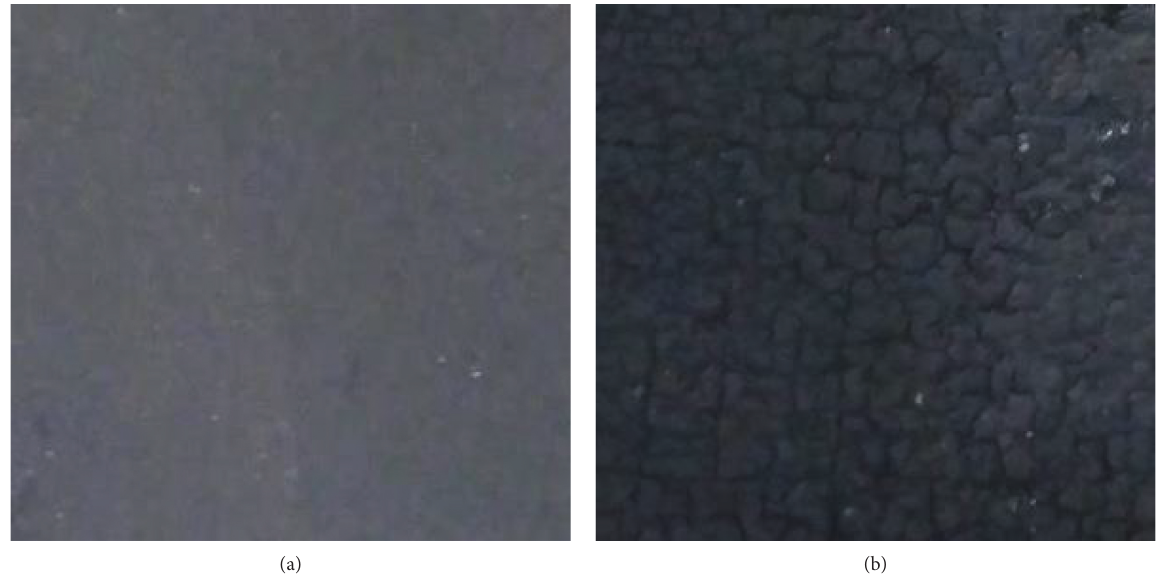
Figure 5: Photographs of the surface of the carbon cloth substance (a) and the CI-WATER ink-coated electrode (b).